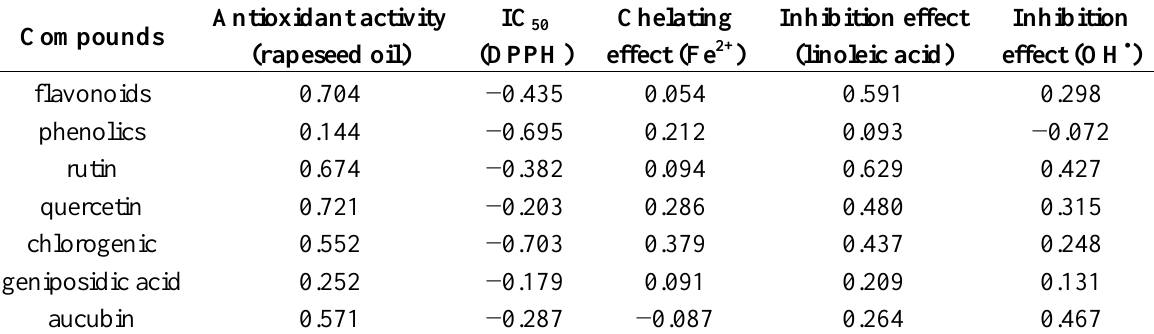
Table 3. Correlation coefficients of the compounds contents with the antioxidant activity.